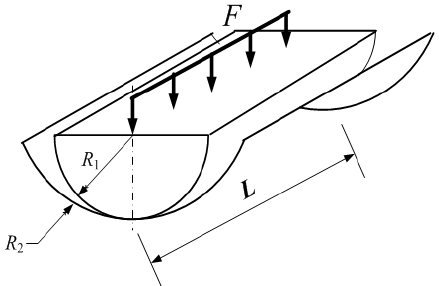
Figure 2. Axis ‐ parallel cylinders’ internal contact.